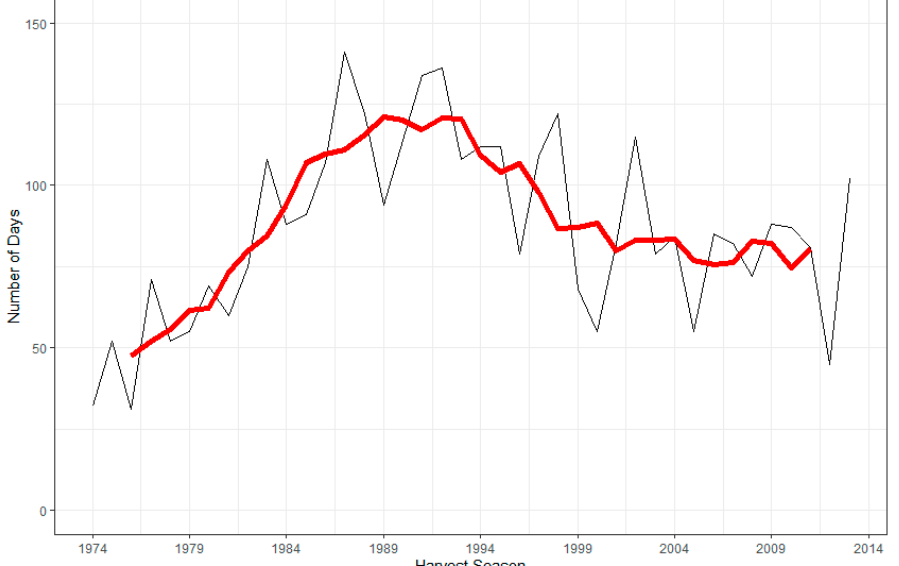
Figure 2. Number of days during harvest months (December–May) with a maximum temperature over 35 °C, 1974–2013, with 5-year rolling average (red line).